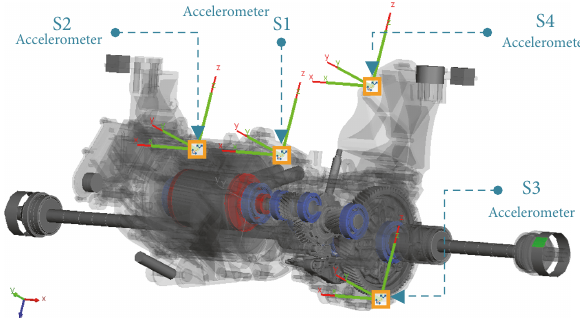
Figure 4: Illustration of the sensor positions, namely, S1, S2, S3, and